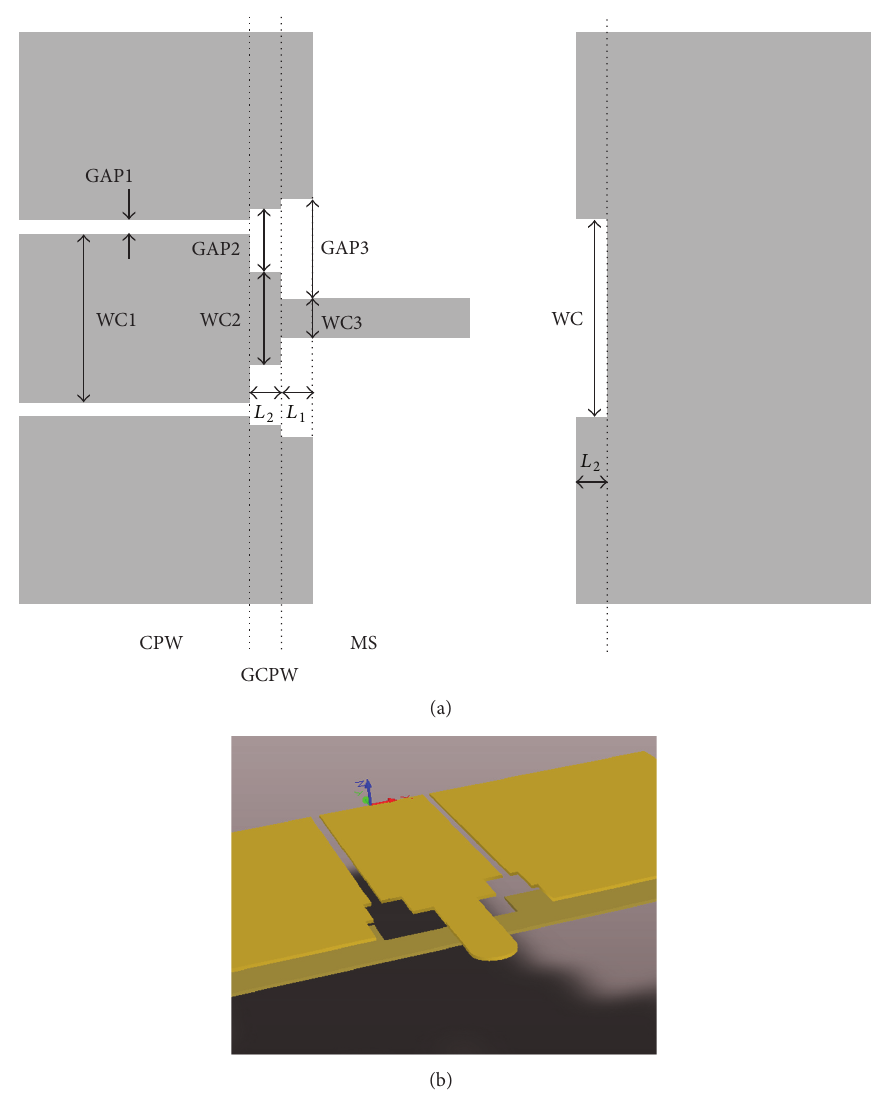
Figure 3: CPW-to-microstrip transition dimensions (a) and 3D footprint